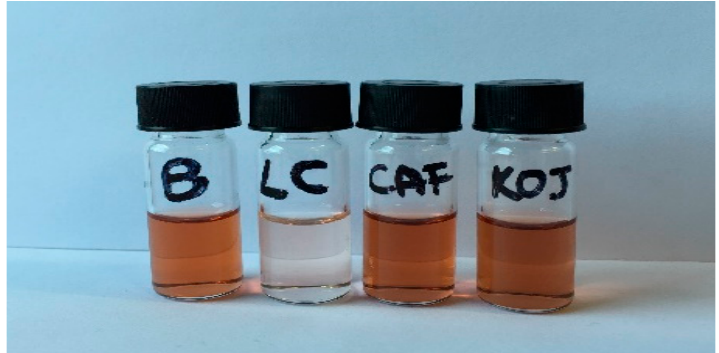
Figure 4. Tyrosinase ‐ catalyzed oxidation mixtures of L ‐ DOPA (1 mM) in the absence (B) or in the presence of 10 μ M inhibitor (LC: 2 ‐ S ‐ lipoylcaffeic acid; CAF: Caffeic acid; KOJ: Kojic acid).